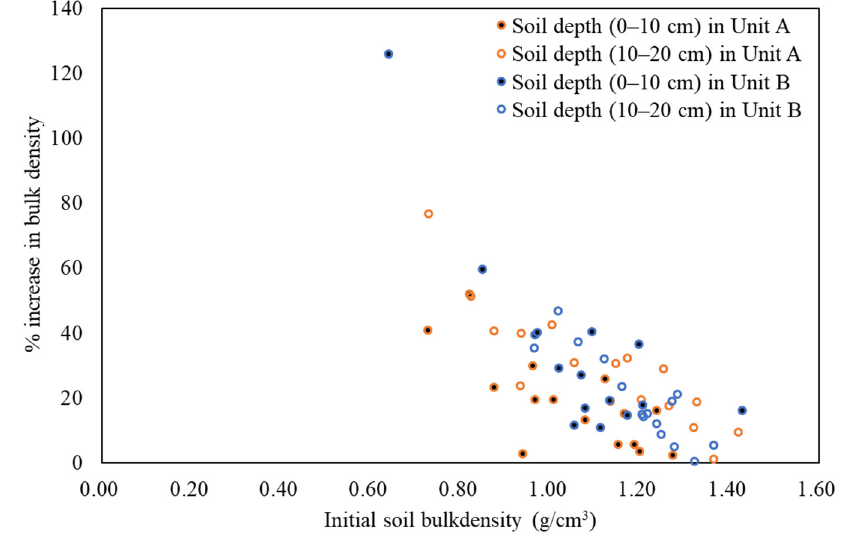
Figure 4. The correlation between initial soil bulk density and percent increase in bulk density.